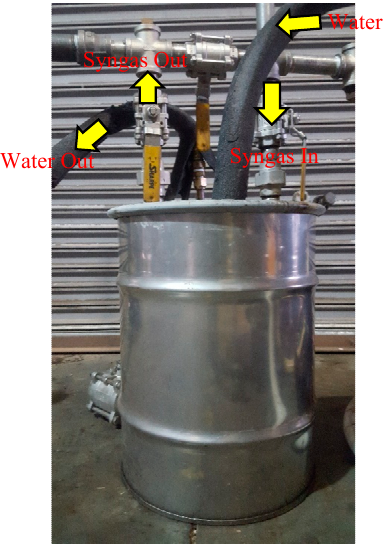
Figure 6. Oil bubbler unit for treatment III.